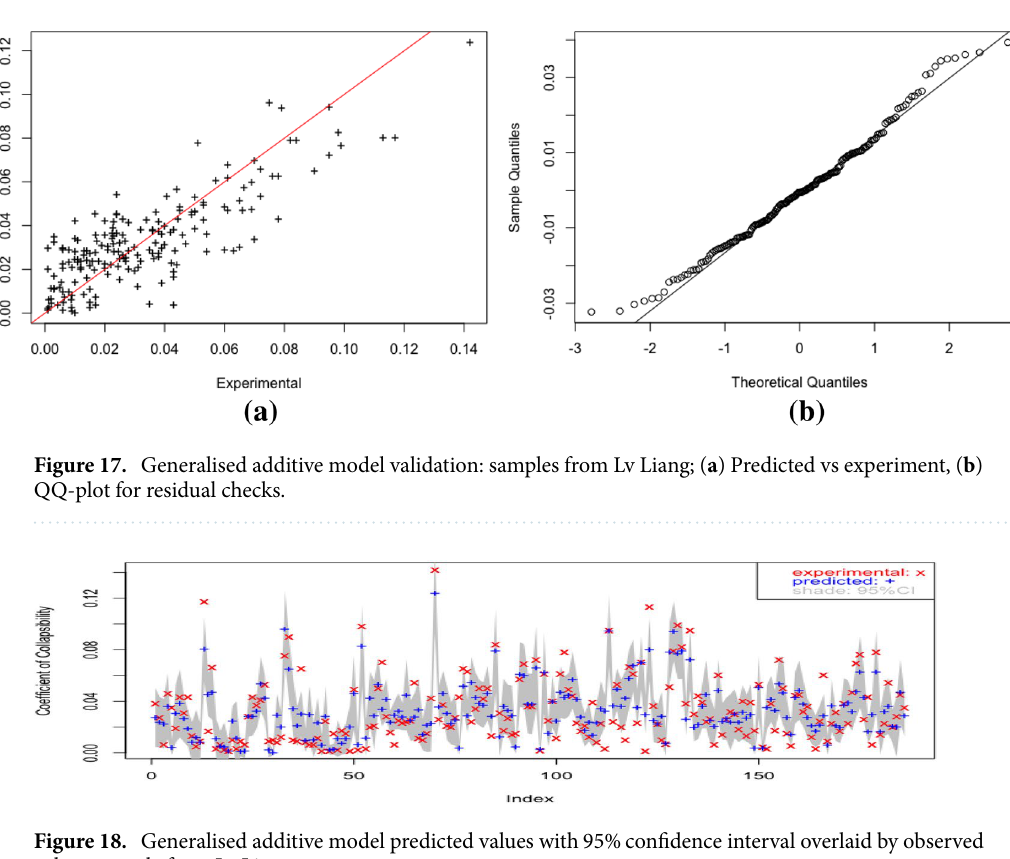
Figure 18. Generalised additive model predicted values with 95% confidence interval overlaid by observed values: sample from Lv